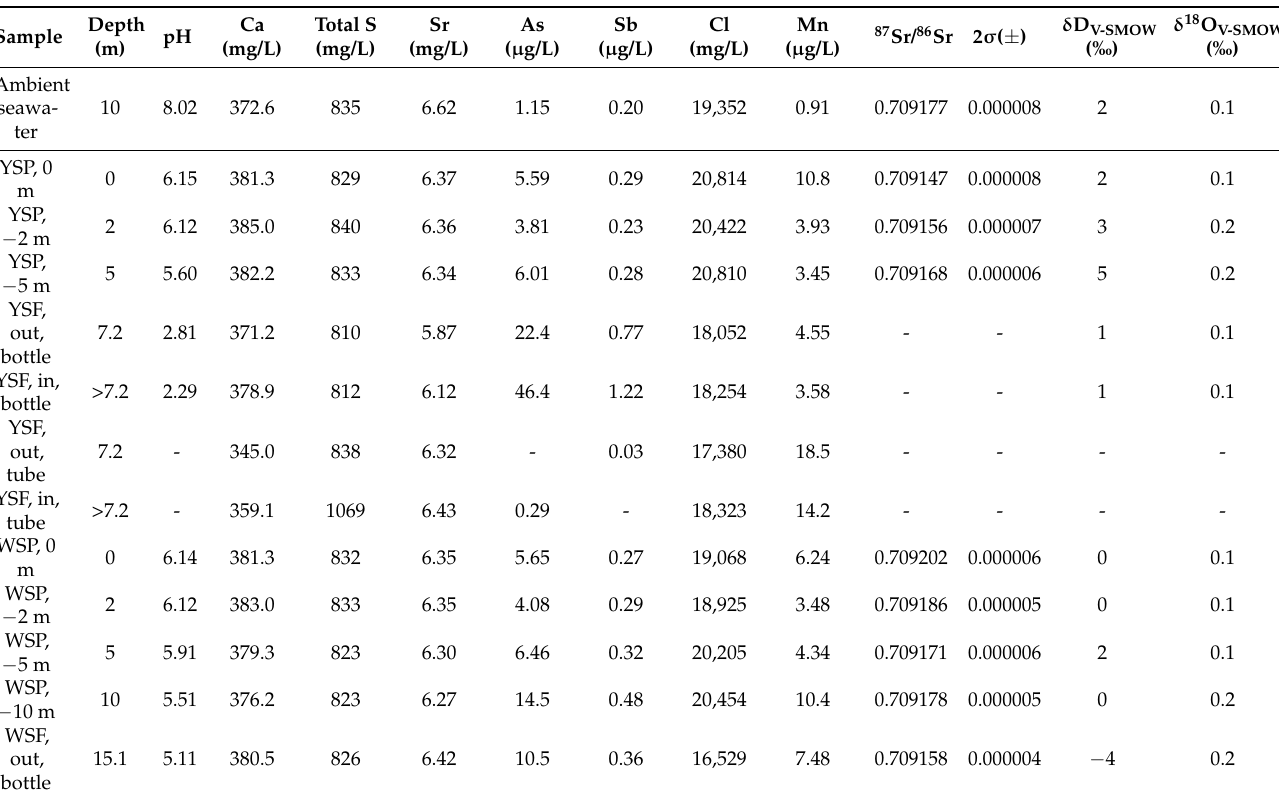
Table 2. pH, Ca, total S, Sr, As, Sb, Cl and Mn concentrations and 87 Sr/ 86 Sr, δ D V-SMOW